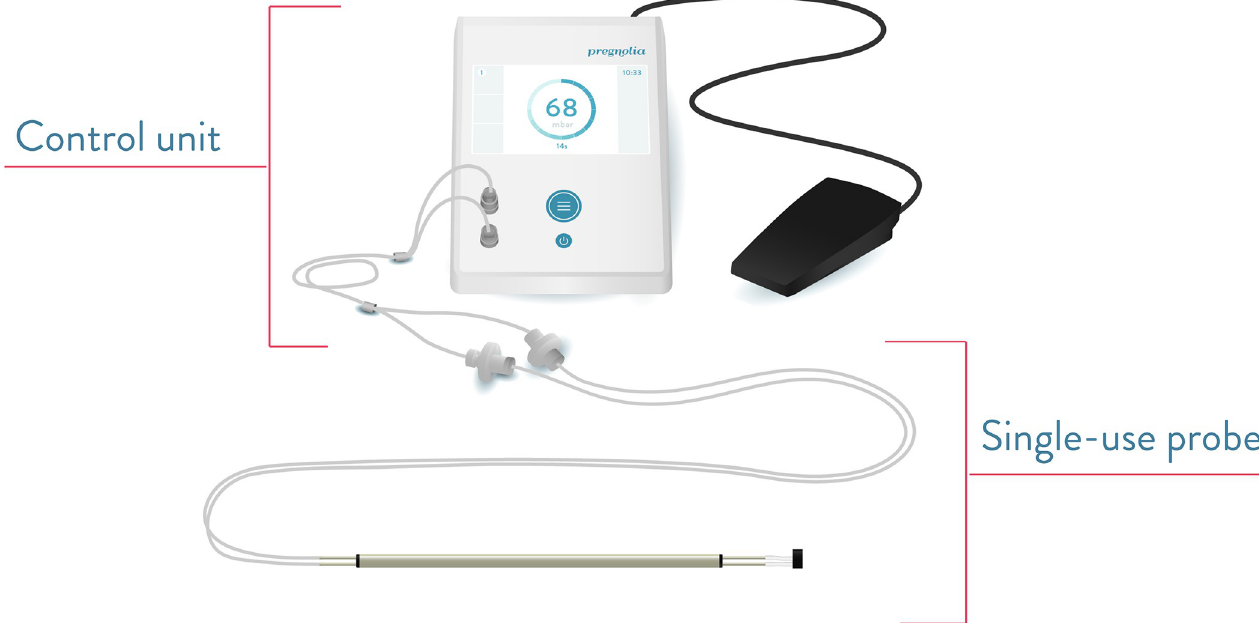
Fig 1. System components: Control unit including control unit console, power supply (not shown), foot switch, connector cable and single-use probe. From the Instructions for Use of the Pregnolia System (www.pregnolia.com/instructions).